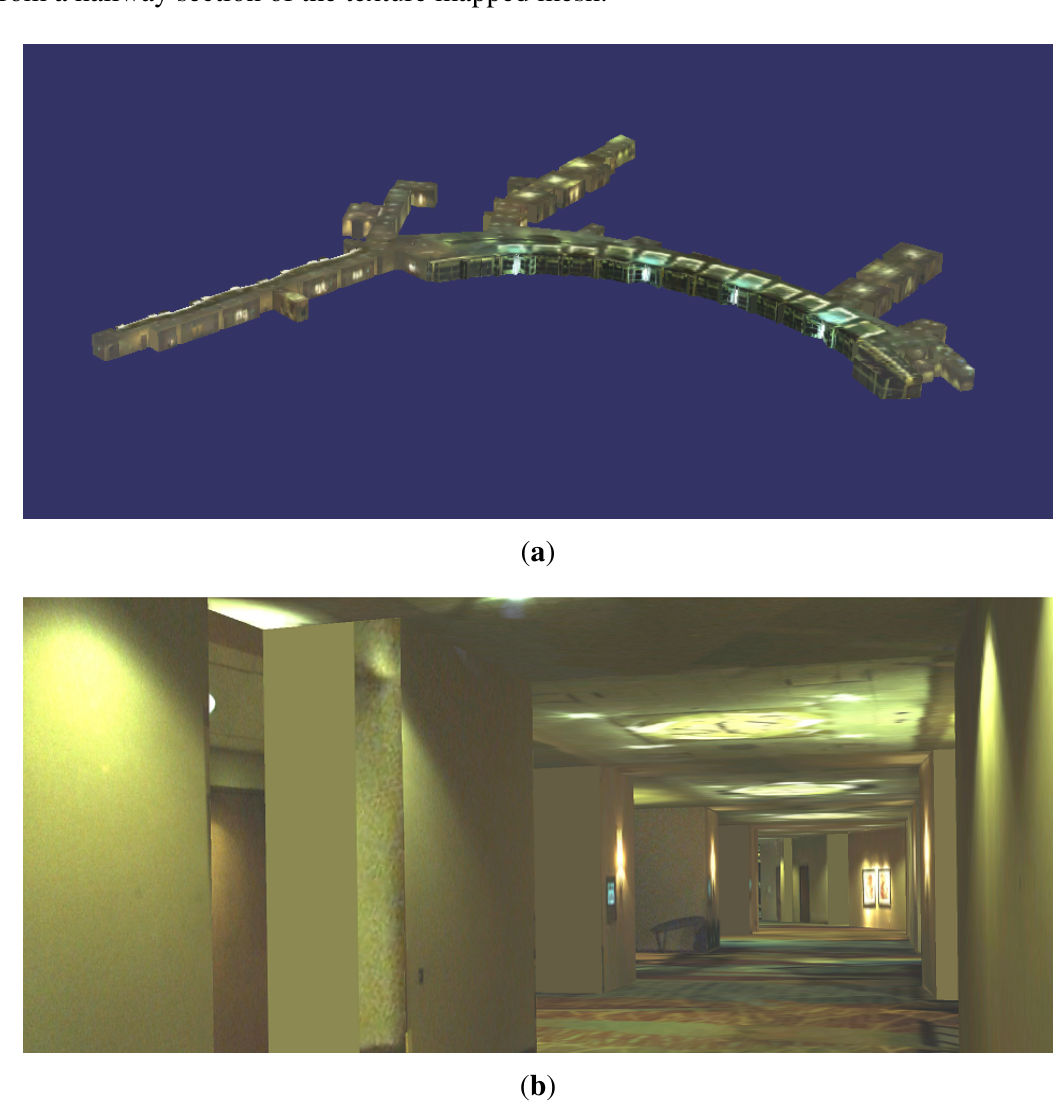
Figure 19. ( a ) A photo-realistic texture mapping of a watertight mesh. ( b ) An interior view from a hallway section of the texture mapped